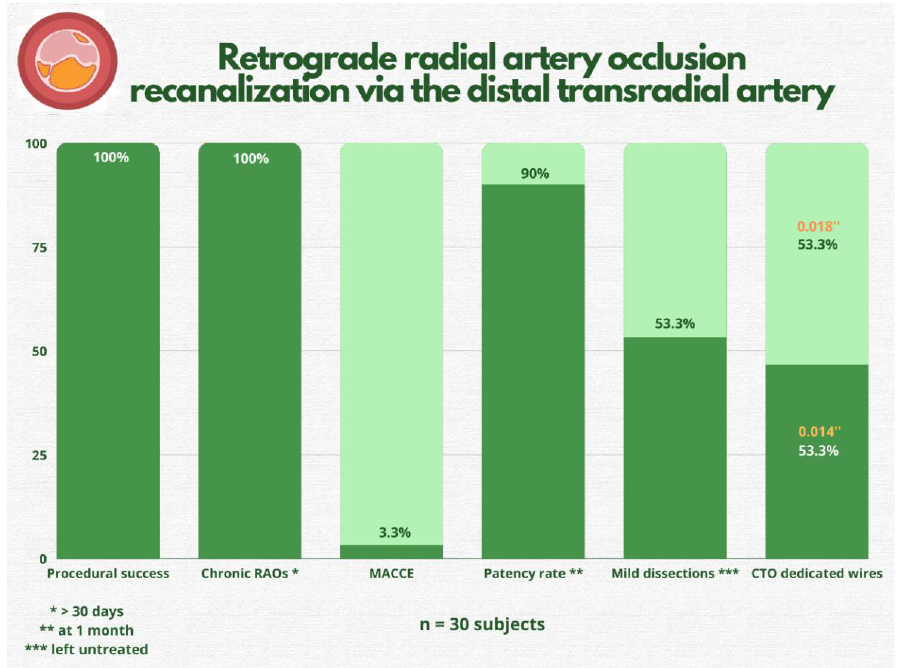
Figure 2. Study ’ s most important findings. RAO = radial artery occlusion; MACCE = major adverse cardiac and cerebrovascular events; CTO = chronic total occlusion.